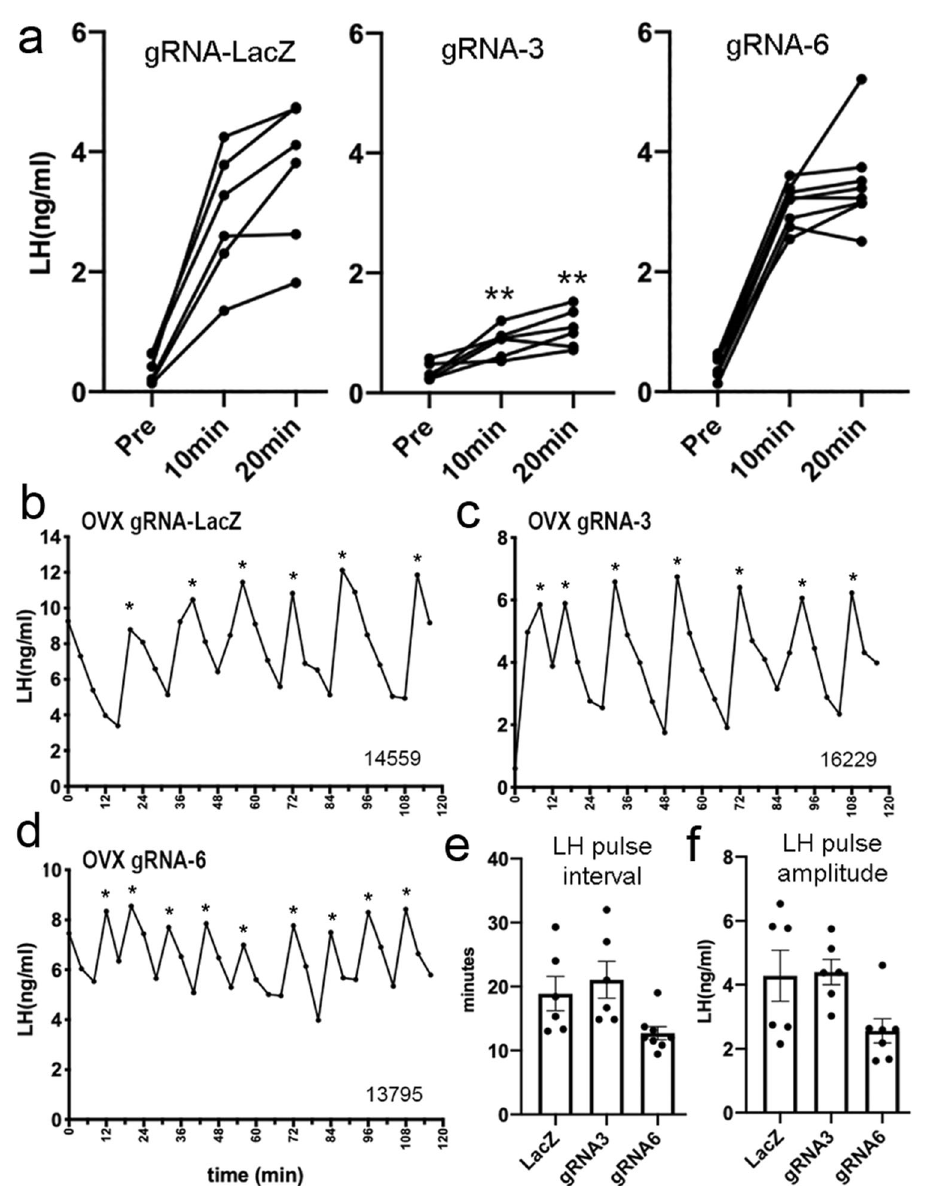
Fig.7|Pituitaryfunctionandeffectsofovariectomyinmicewithknockdownof ESR1 in adult ARN KISS neurons. a Individual pro fi les of LH secretion in mice from the three gRNA groups showing LH levels before (Pre) and then 10 and 20 min following a bolus s.c. administration of GnRH. ** P =0.002 at both time points versus LacZ (Mann – Whintey). b – d Representative LH pulse pro fi les obtained from 3-weekovariectomizedmicefromthethreegRNAgroups.Asterisksindicatepulses